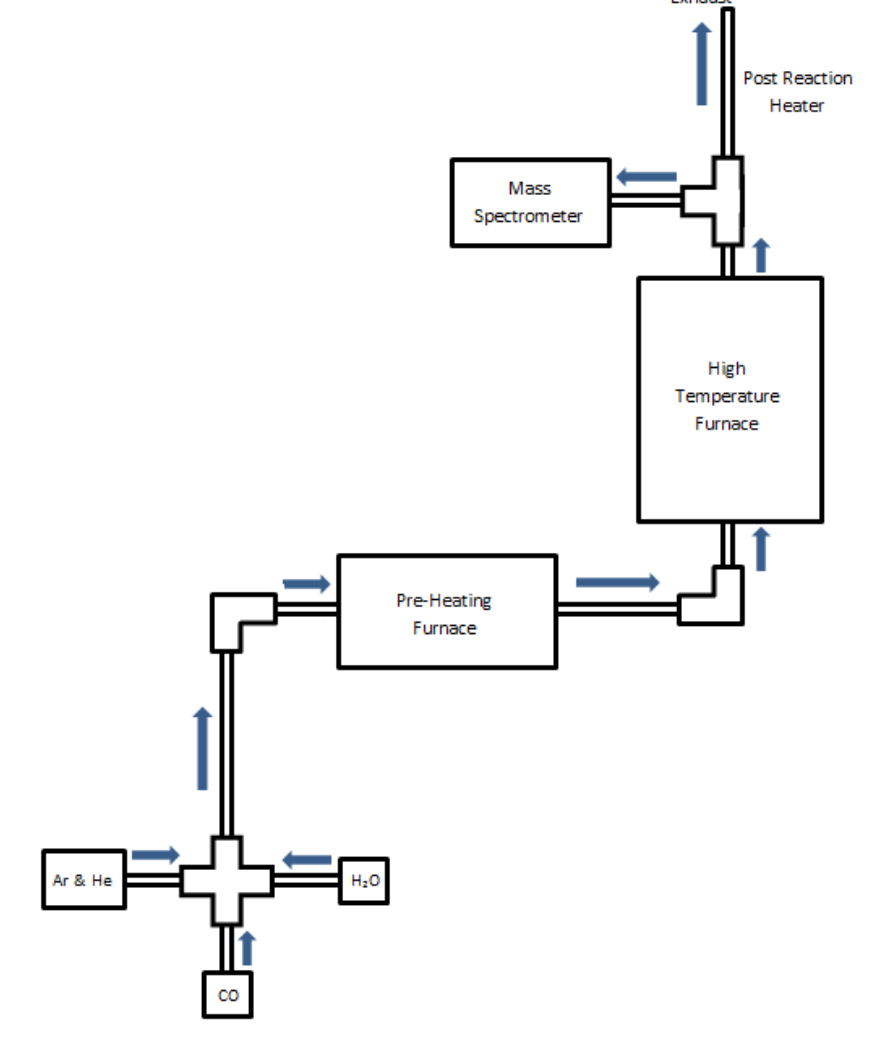
Figure 1. Monolithic reactor schematic designed for redox